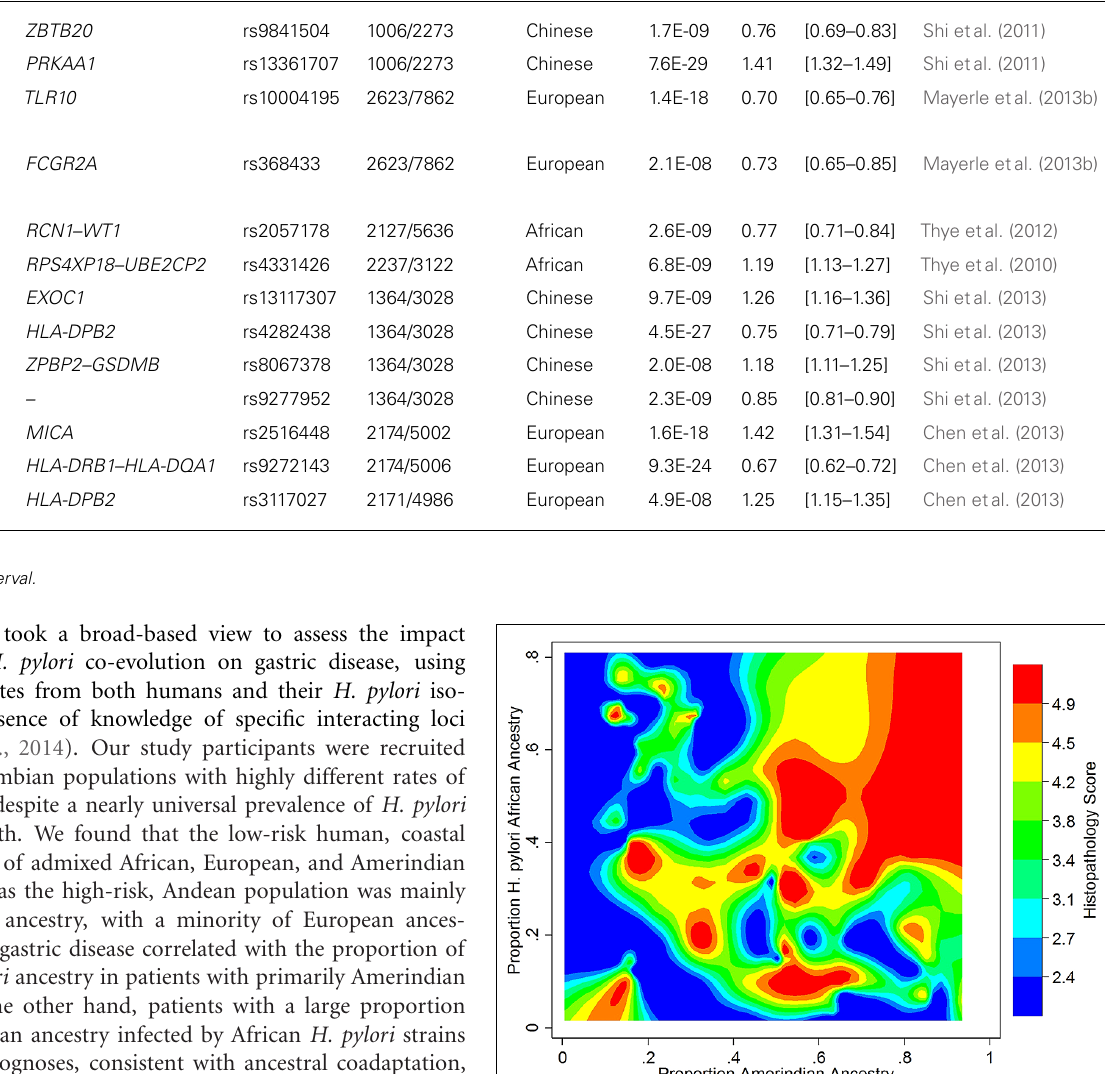
Table 1 | Genetic variants identified by GWAS for phenotypes related to infection by H. pylori , M. tuberculosis , and human papillomavirus. Disease/trait